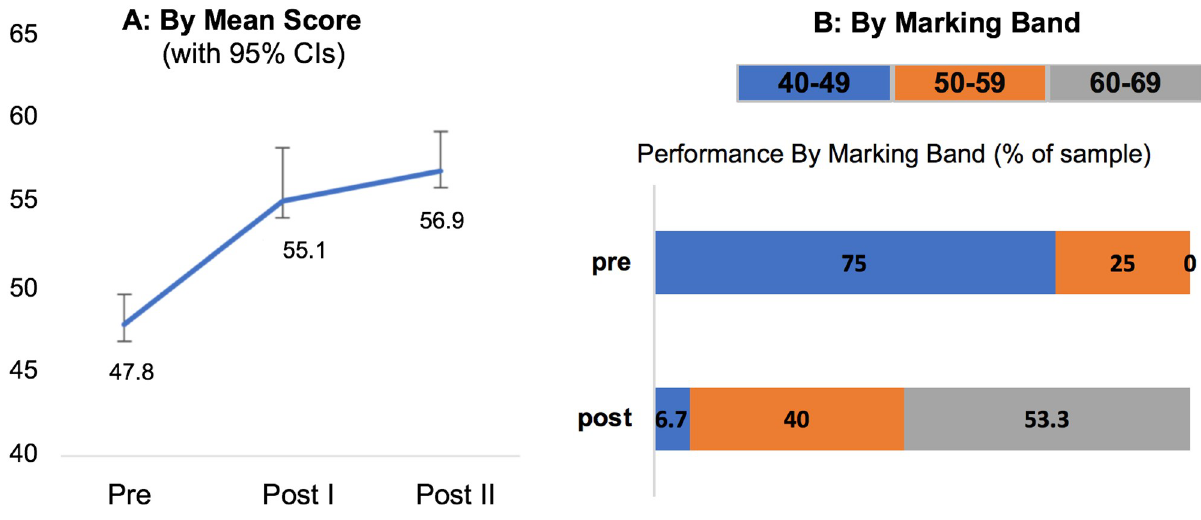
Fig 5. Changes in physiotherapist